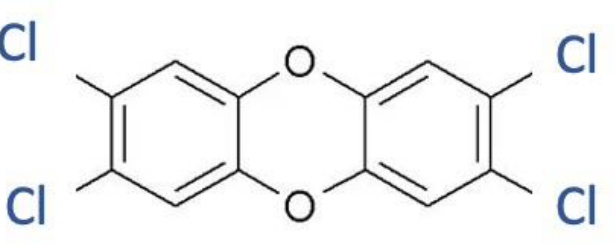
Figure 1. Chemical structure of TCDD .